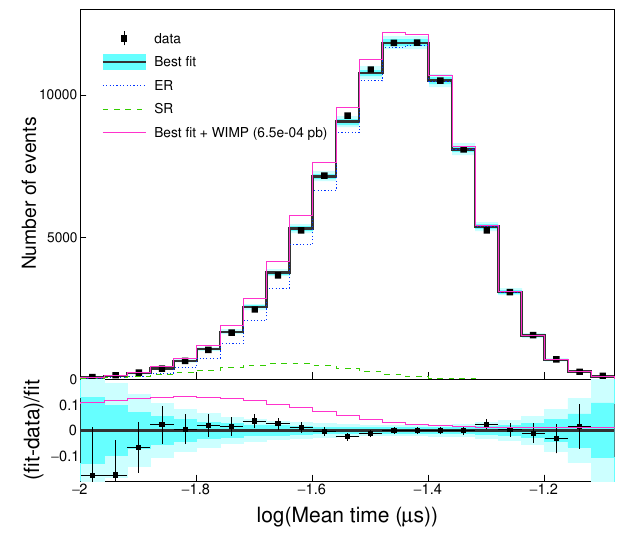
Figure 7 . The accumulated LMT spectrum for all energy bins in the ROI and the two crystals from the data (square point) and best (cid:12)t model (solid line with shaded band corresponding to 1- and 2- (cid:27) uncertainties). The (cid:12)tted results for ER events (blue dotted line) and SR events (green dashed line) are indicated. The magenta thin solid line represents the expected signal excess above background for a 10 GeV/c 2 WIMP mass and 6 : 5 (cid:2) 10 (cid:0) 4 pb cross section which corresponds to two times of 90% limit value. The lower panel shows the residuals between the data and the background